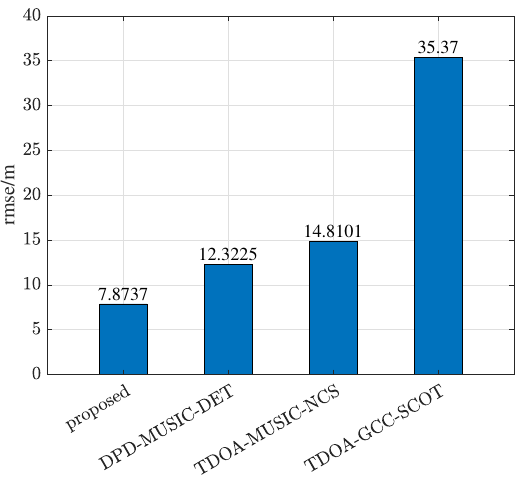
Figure 10. The comparison of RMSE in a real-world positioning